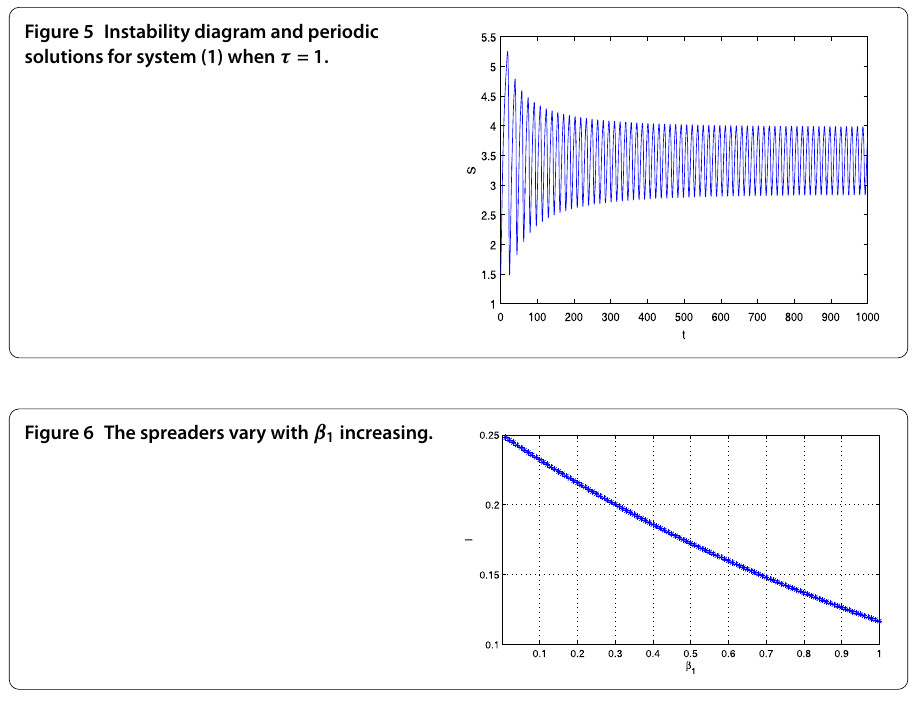
Figure 5 Instability diagram and periodic solutions for system (1) when τ = 1.